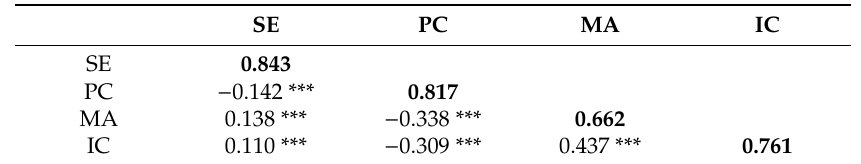
Table 4. Discriminant